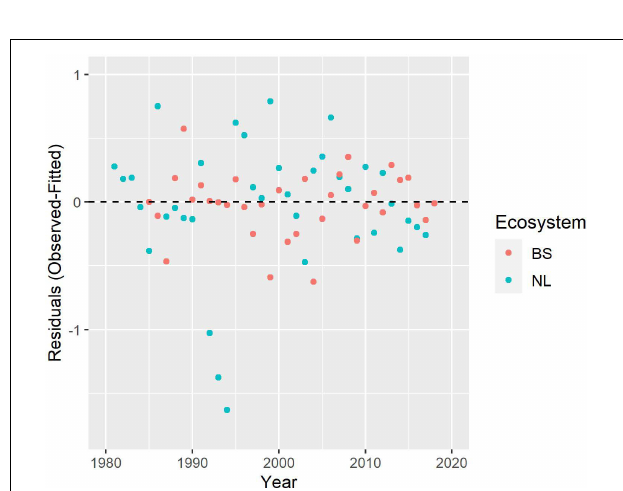
FIGURE 4 | Standardized residuals for the Newfoundland-Labrador shelves (NL) (blue dots) and Barents Sea (BS) (red dots) cod models assuming fully independent stocks (i.e., no common parameters between